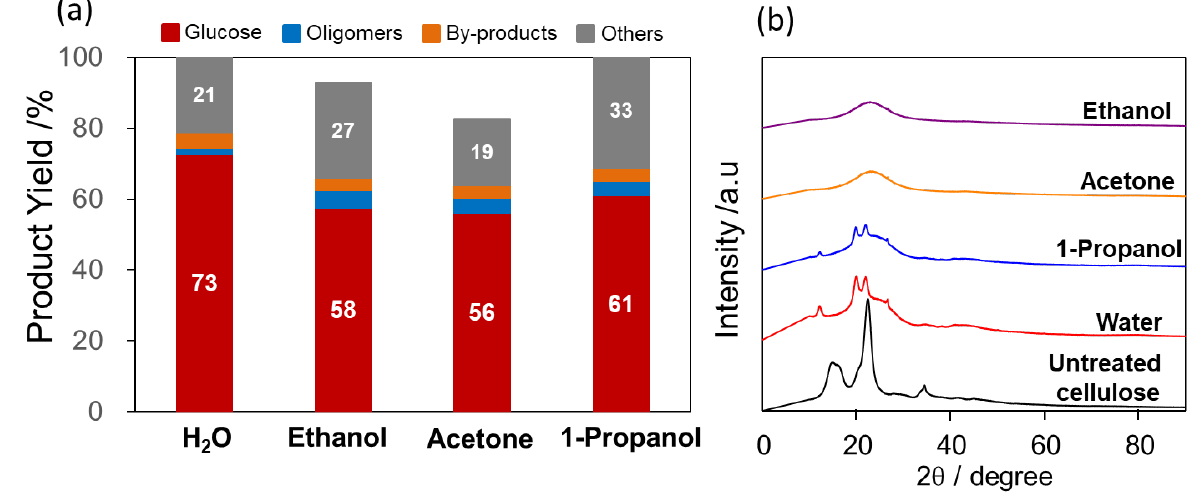
Figure 9. ( a ) Influence of antisolvent during H 3 PO 4 treatment of cellulose during hydrolysis reac- tion. ( b ) X-Ray diffraction patterns for cellulose precipitated in different antisolvent after dissolution in H 3 PO 4 .